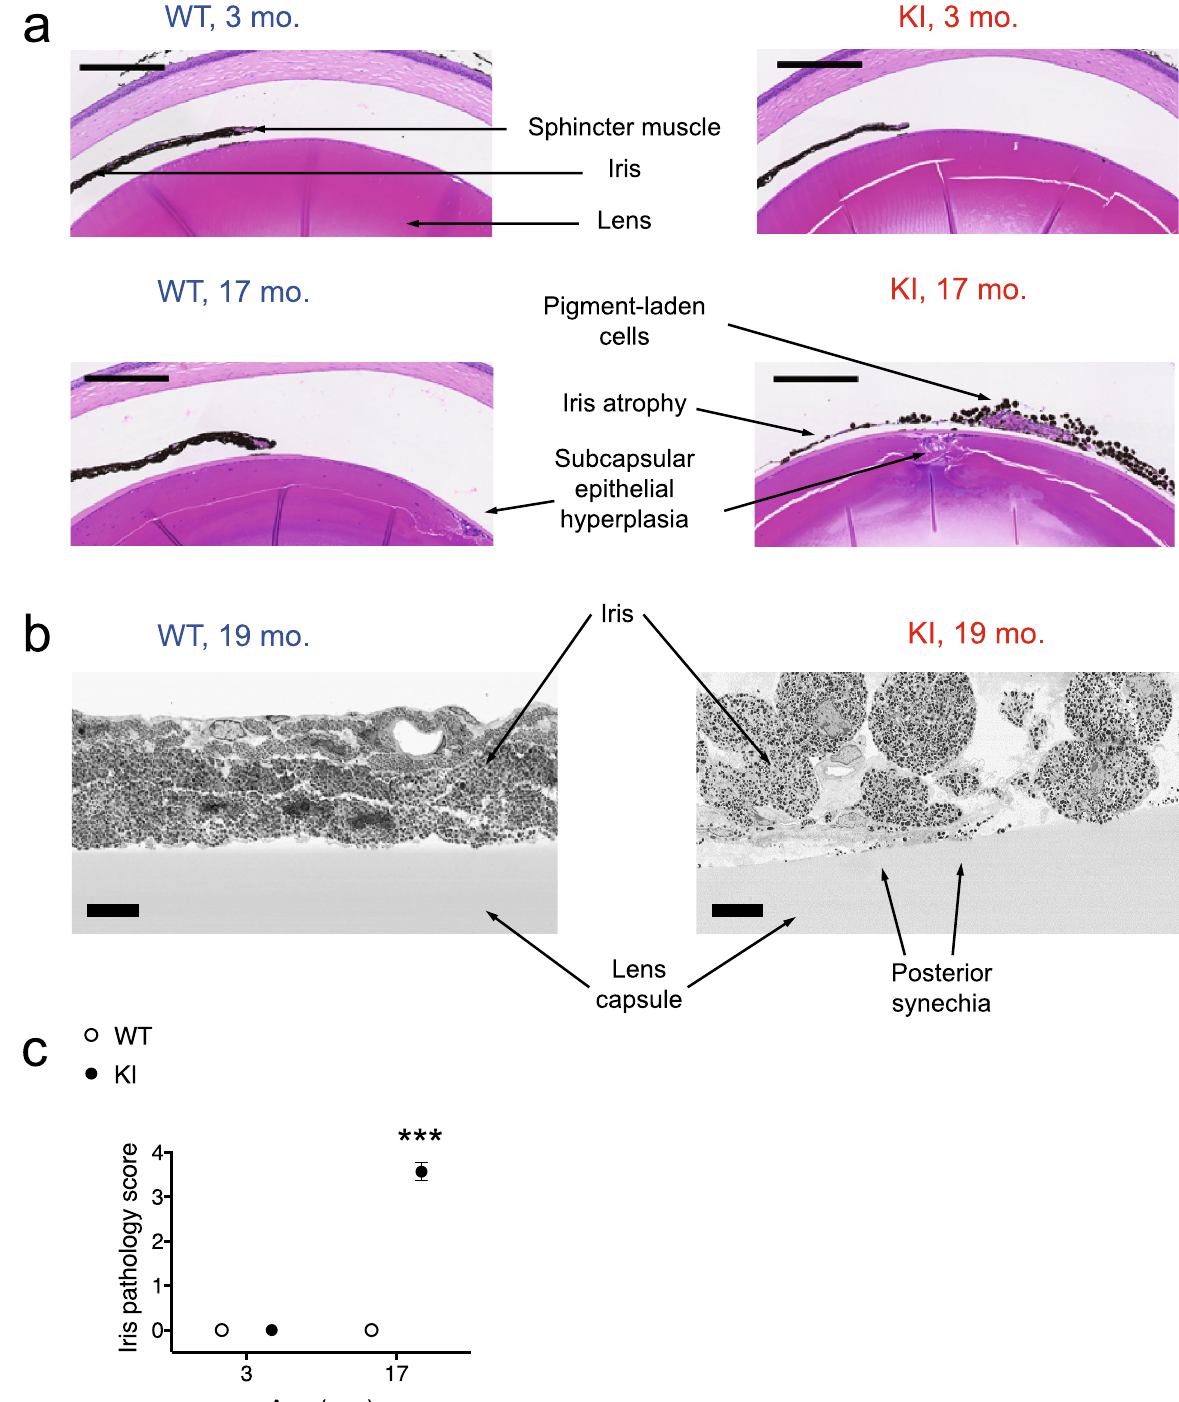
Figure 4. Iris pathology in aged Gba KI mice. ( a ) Representative images taken from sagittal histological cross sections through the globe at the level of the optic nerve at higher magnification in 3- versus 17-months old Gba WT and KI mice. Note stromal atrophy and pigment dispersion in the iris of aged Gba KI mice (bottom right). Posterior synechia were significantly more frequent in aged Gba KI mice (Supplementary Table S2). Cataracts and foci of anterior pole subcapsular epithelial hyperplasia occurred more frequently in lenses of aged mice (Supplementary Table S4). The scale bar denotes 200 µm. ( b) Representative SEM-EM images taken from the iris and the lens capsule in 19-months old Gba WT (left panel) and KI (right panel) mice. The scale bar denotes 10 µm. ( c ) An iris pathology score was established based on the aggregation of four individual, categorial, iris-related phenotypes (stromal atrophy, pigment dispersion from the iris, accumulation of pigment-laden cells in the iridocorneal angle (see below), and posterior synechia) yielding a scale with a range from 0 to 4. Iris pathology was pronounced in aged Gba KI mice but absent in all other groups (Supplementary table